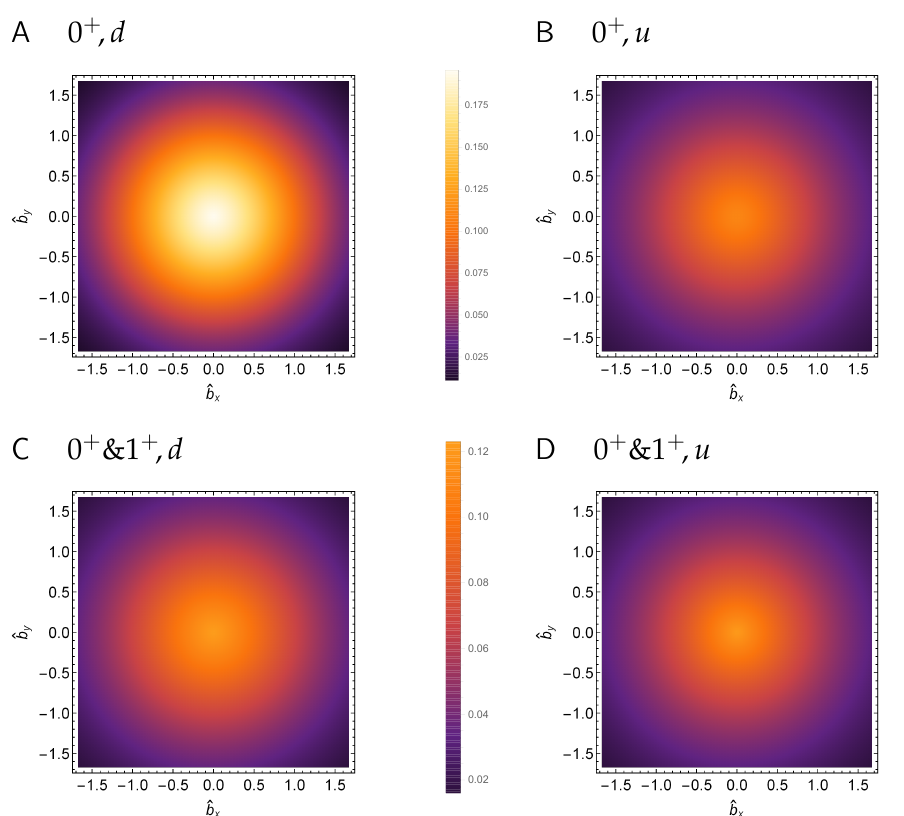
Figure 17. Transverse density profiles, Equation (48), calculated in Reference[276] from flavour-separated proton axial form factors. Top row: scalar-diquark-only proton. Panel A : two-dimensional plot of ˆ ρ d ( | ˆ b | ) / g u Panel B : similar plot of ˆ ρ u . Removing the 1/ g f A A ( 0 ) = 0.097. Bottom row: realistic proton Faddeev amplitude, including axial vector diquarks as ρ u A predicted by the Faddeev equation in Figure 8. Panel C : ˆ ρ d the 1/ g f normalisation, the b = 0 values of these profiles are ˆ ρ d A (cid:82) ( | ˆ b | ) / g f = 1, f = u , d d 2 ˆ b ˆ ρ f A A